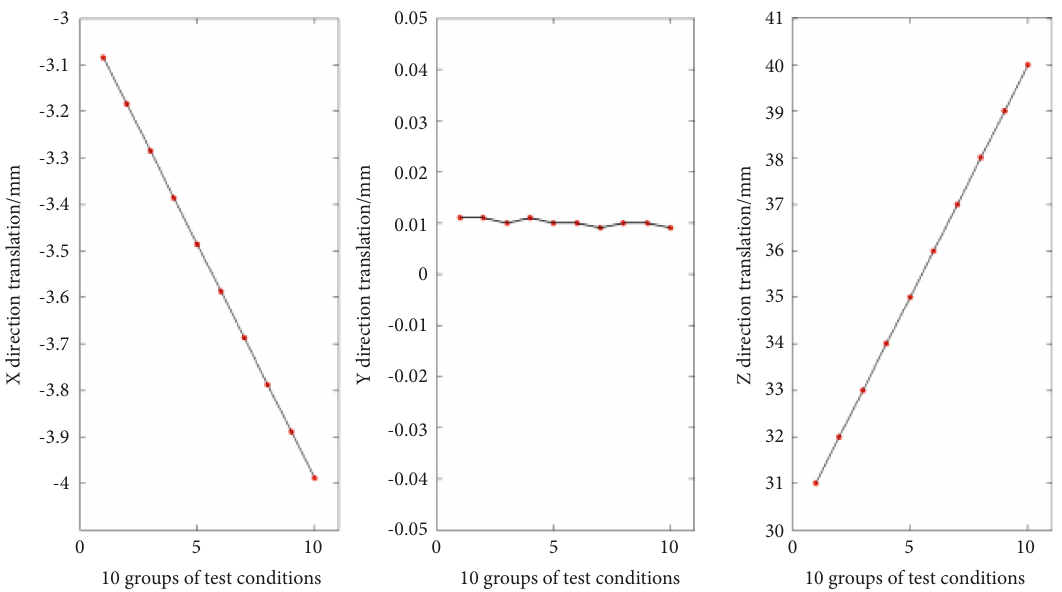
Figure 16: Results of the last 10 groups of change in the 3-DOF PSD translation.